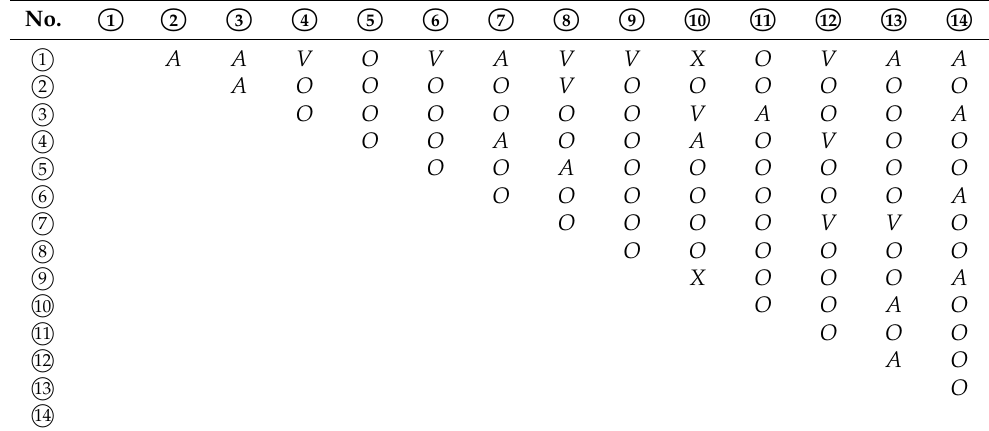
Table 3. The SSIM result of